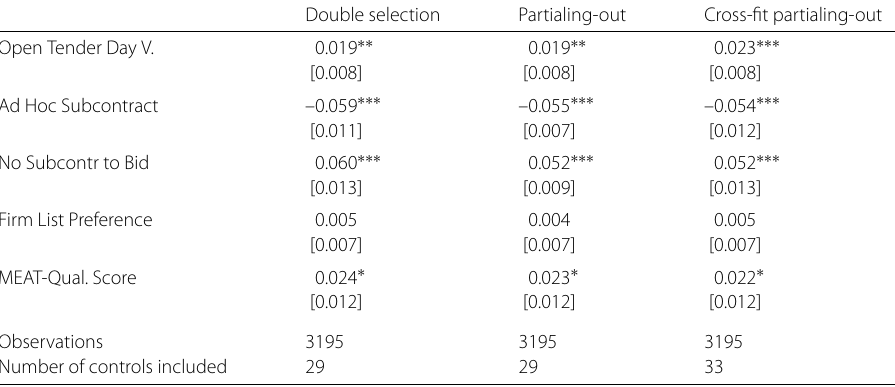
Double selection Partialing-out Cross-fit partialing-out Open Tender Day V.